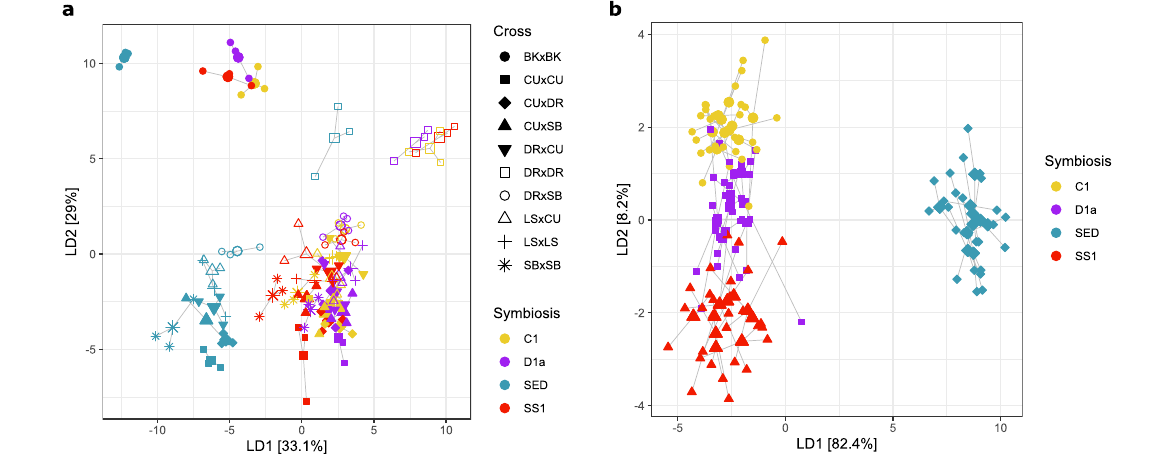
Fig.2|Juvenilegeneexpressionresponsestosymbiosis. Discriminantanalysisof principal components (DAPC) on gene expression of juveniles hosting different symbioses under ambient conditions. DAPC was performed on variance stabilized